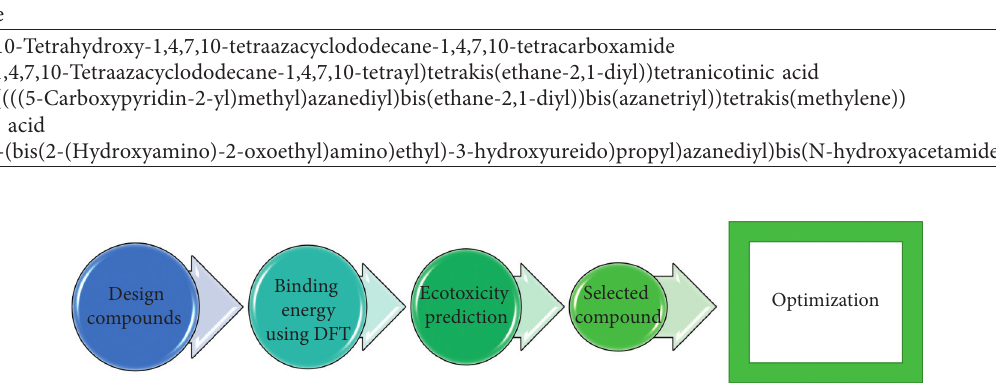
Figure 1: Flow chart depicting novel designing of novel chemicals for iron sulfide scale inhibition.